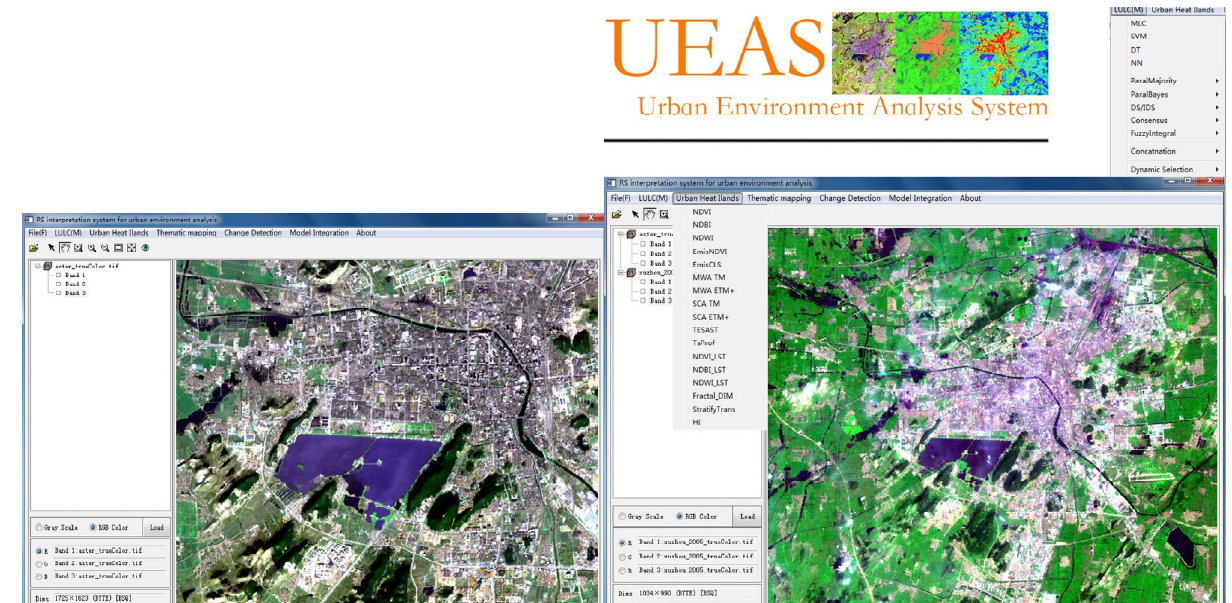
Figure 2. Graphic user